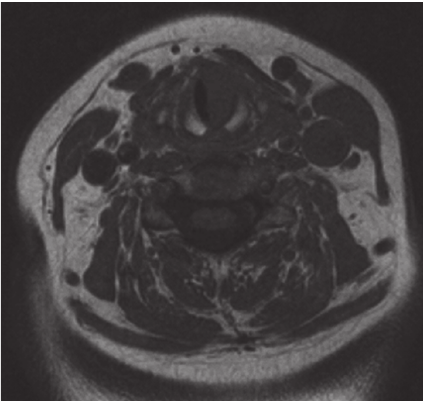
Figure 3: T1-weighted MRI scan showing homogenous soft tissue mass in the left subglottic region.